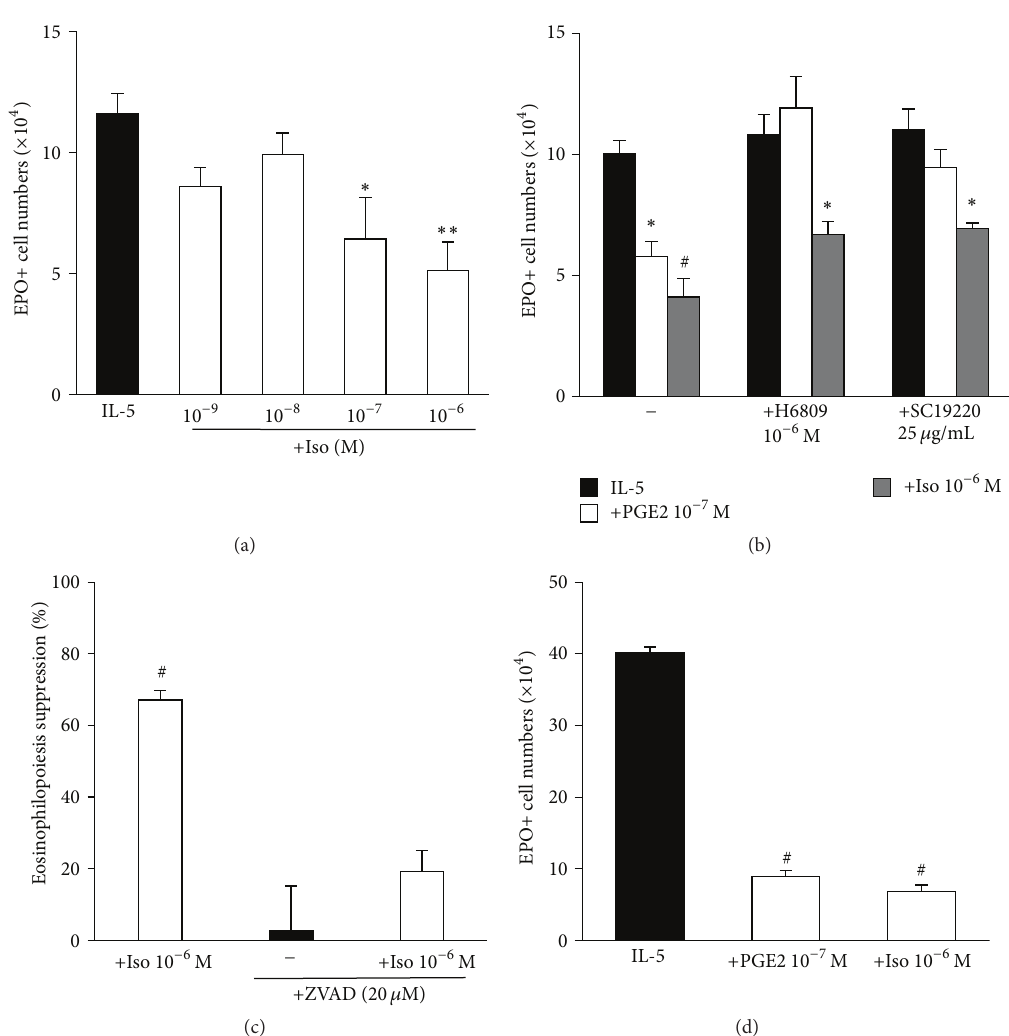
Figure 3: Isoproterenol duplicates the effects of PGE2 by acting at different receptors in a caspase-dependent, flt3L /SCF-sensitive way. (a)–(c) Bone-marrow cultures were established in the presence of IL-5, alone or associated with PGE2, isoproterenol (Iso), caspase inhibitor zVAD- fmk (ZVAD), EP2 antagonist H6809, EP4 antagonist SC19220, or the indicated combinations of these agents, which were all present from the beginning of culture for a 7-day period. (d) Bone-marrow cultures were primed with flt3L -SCF [22] for 4 days and further cultured for 4 days with IL-5 alone or associated with PGE2 and Iso. Data (mean + SEM; 𝑛 = 4 in (a), 𝑛 = 3 remaining panels) are the numbers of EPO+ cells recovered at the end of the culture ((a), (c), and (d)) or the % eosinophilopoiesis suppression in the indicated conditions, where inhibitors were used to prevent this suppression (b). Significant differences relative to the respective IL-5 controls: ∗ 𝑃 ≤ 0.05 , ∗∗ 𝑃 ≤ 0.01 , § 𝑃 ≤ 0.005 , # 𝑃 ≤ 0.0025